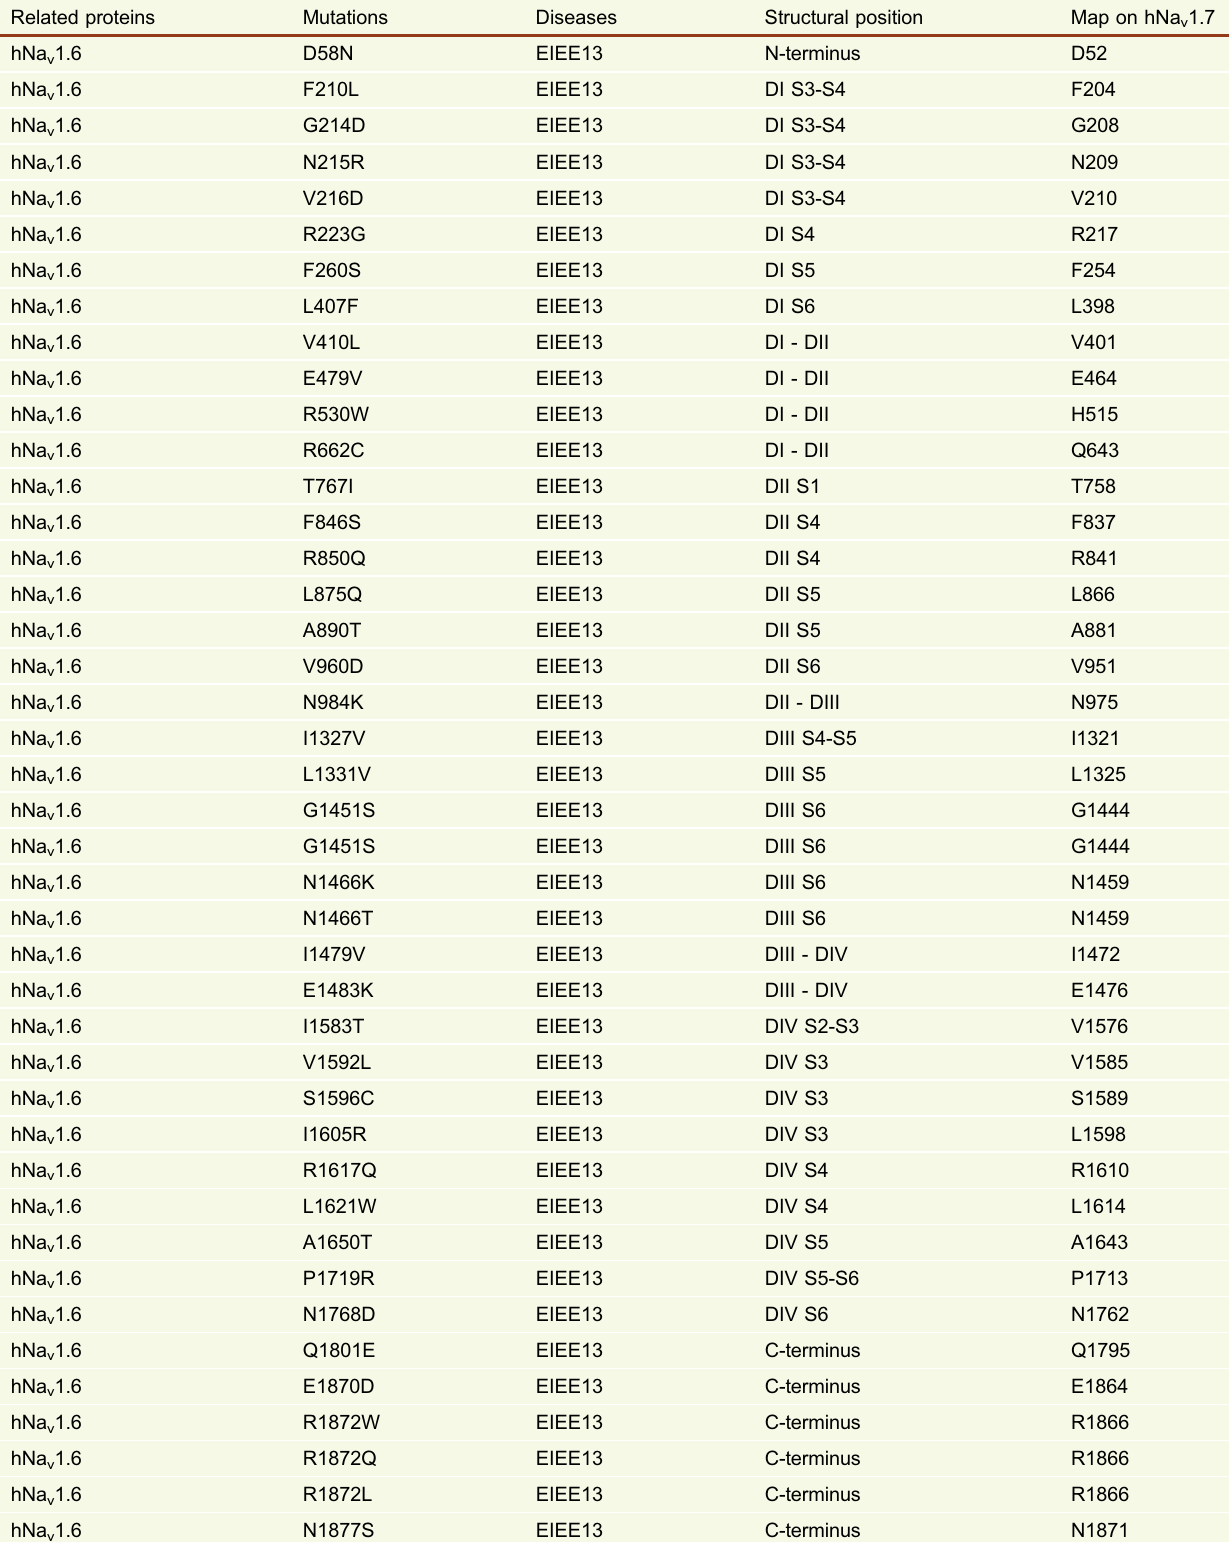
Table 7. Structural mapping of disease-related mutations identi fi ed in human Na v